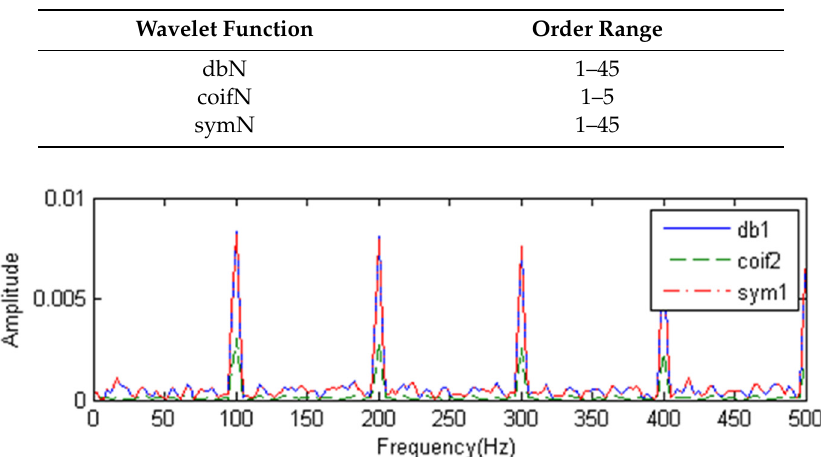
Figure 3. The results of the envelope analysis.